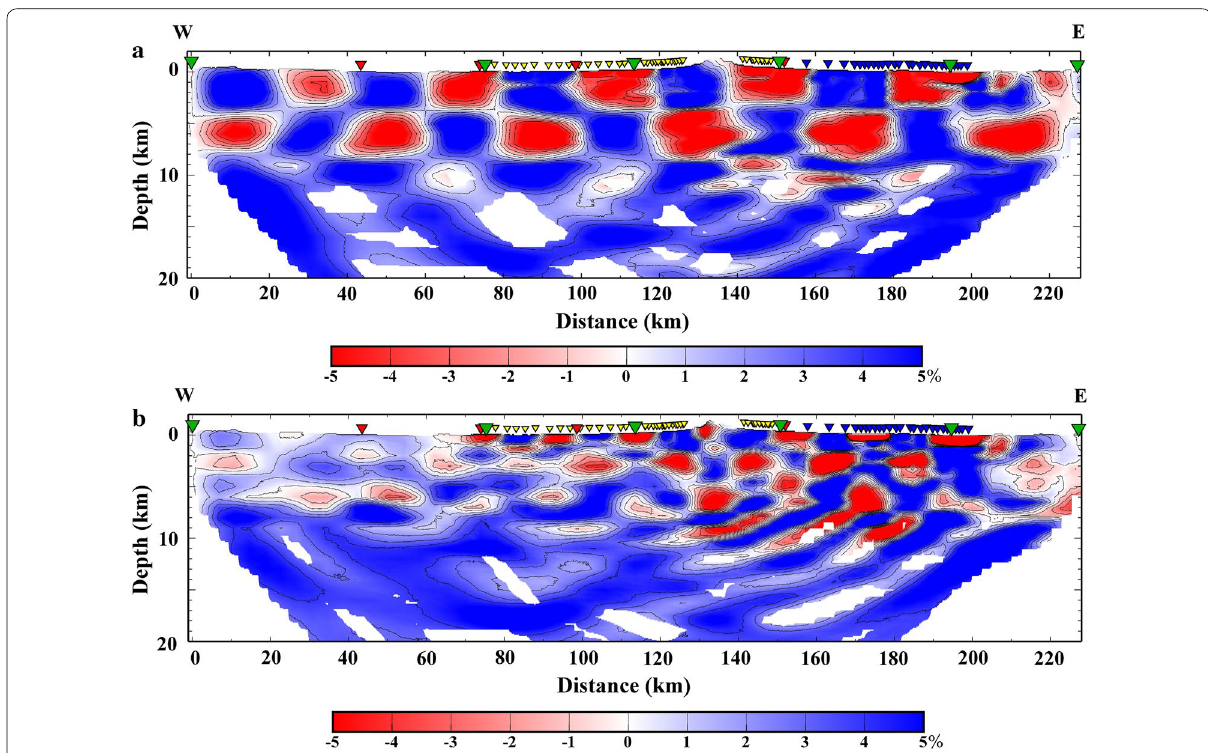
Fig. 4 Results of checker board test. a Case for anomaly size of 20 km (Horizontal) x 5 km (vertical). Shot positions used in the tomography analysis are indicated by triangles. b Case for anomaly size of 10 km x 3